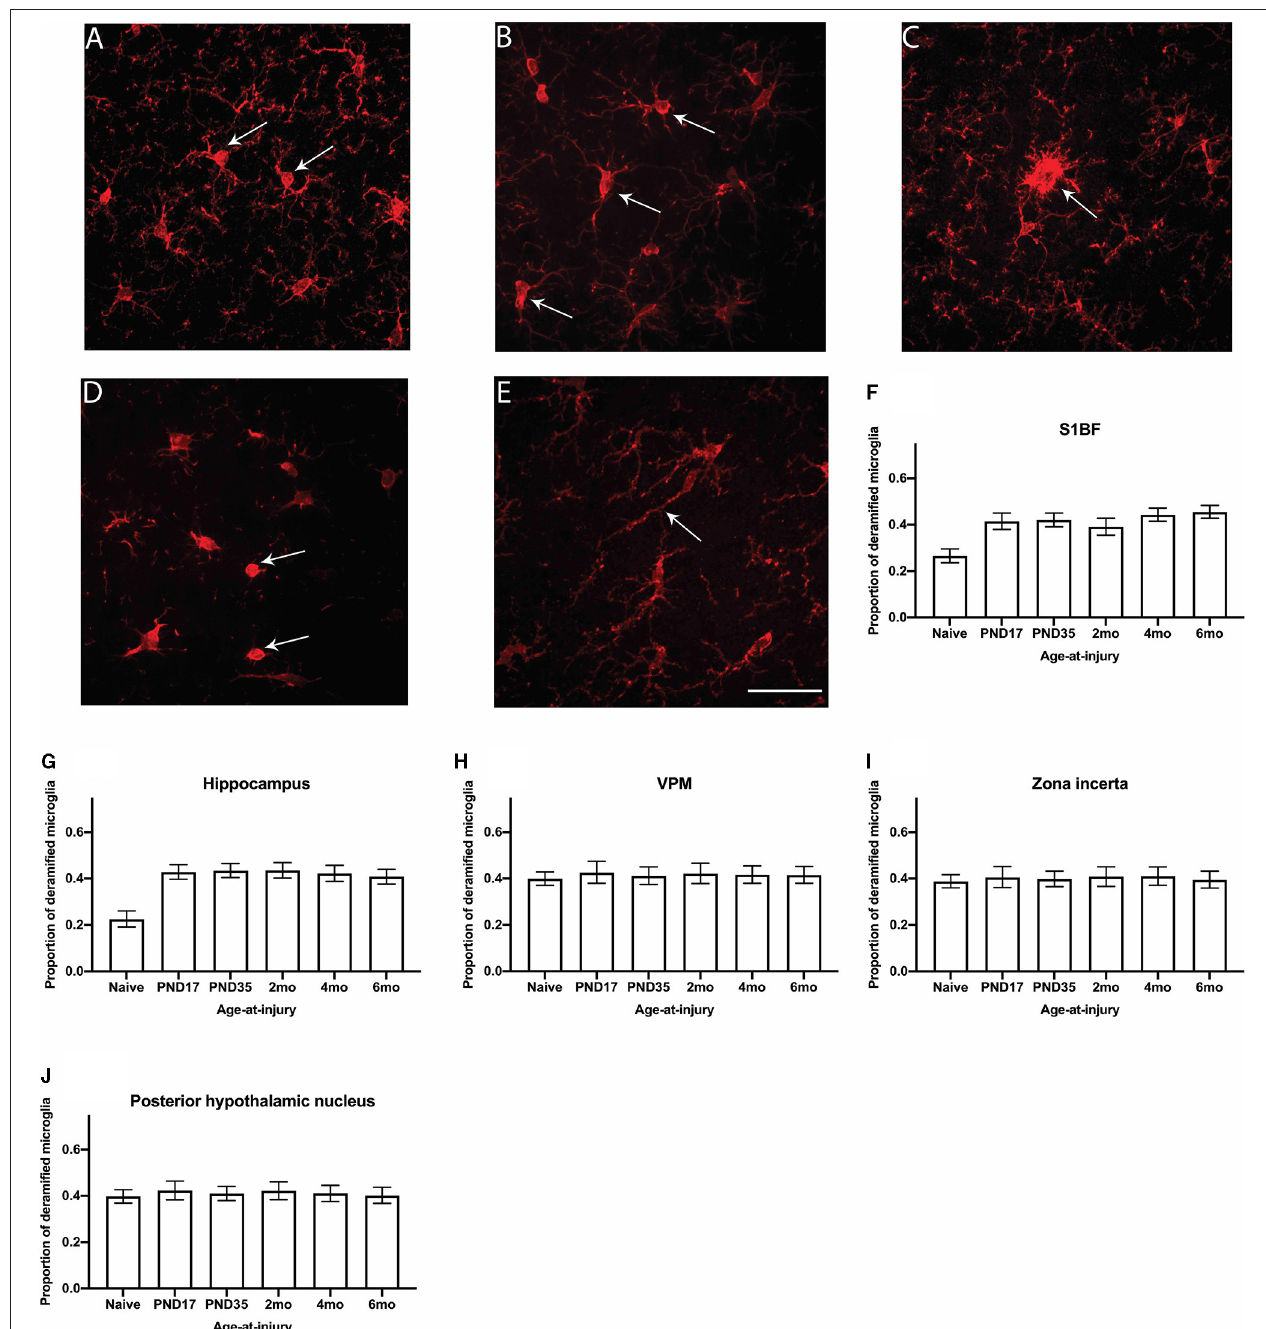
FIGURE 6 | The proportion of deramified microglia were quantified in the S1BF, hippocampus, VPM, zona incerta, and posterior hypothalamic nucleus. Representative images of ramified (A) and deramified (B–E) microglia, indicated by the black arrows (scale bar = 50 µ m), visualized by Iba1 immunohistochemistry were taken in the primary sensory barrel field (S1BF) of rats injured at 6-months of age. The proportion of deramified microglia (mean ± 95%CI) was determined in the S1BF, hippocampus, ventral posteromedial nucleus (VPM), zona incerta, and posterior hypothalamic nucleus. There was a significantly greater proportion of deramified microglia observed after brain injury, regardless of age-at-injury, compared to naïves in the S1BF (F) , hippocampus (G) but not in the zona incerta (H) , VPM (I) , or posterior hypothalamic nucleus (J) . with reduced complexity. These morphologies are referred to thin, and highly branched processes [ Figure 6A ; (65)]. After an as hyper-ramified, hypertrophic, and amoeboid [ Figures 6B–D ; injury or infection, microglia undergo de-ramification where the (65)]. In addition to this, microglia have also been documented cell body typically becomes swollen, and processes are retracted